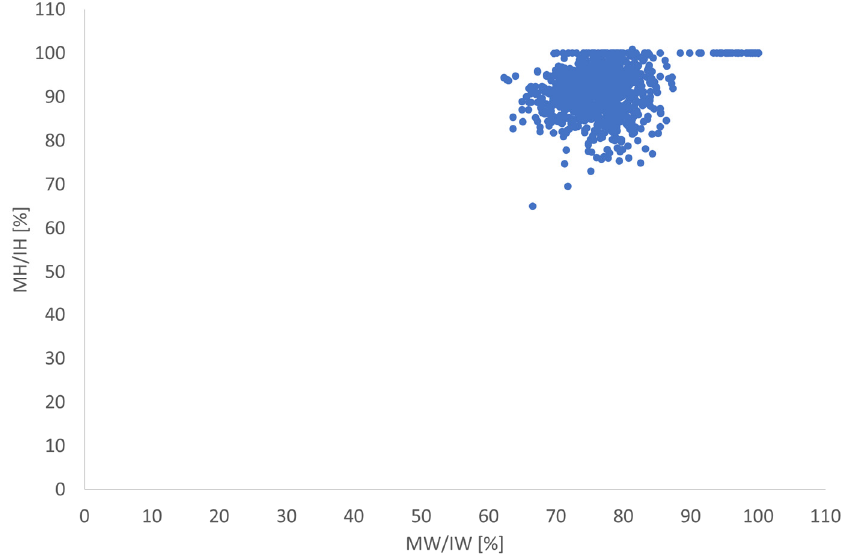
Figure 2. Measured results of head standard. (MH: Measured Height, IH: Image Height, MW: Measured Width, IW: Image Width).